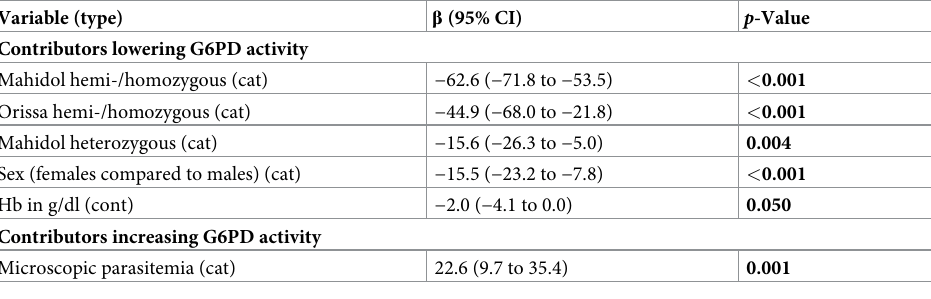
Table 5. Significant predictors of non-normalized G6PD activity among participants with known G6PD variant.